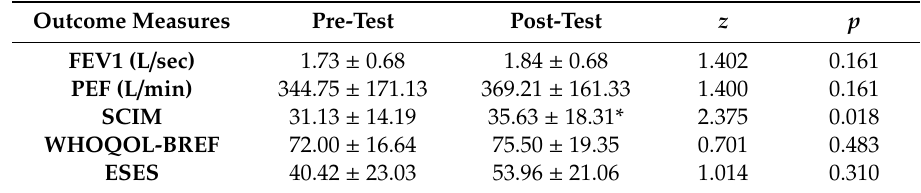
Table 2. Results of Pre and Post